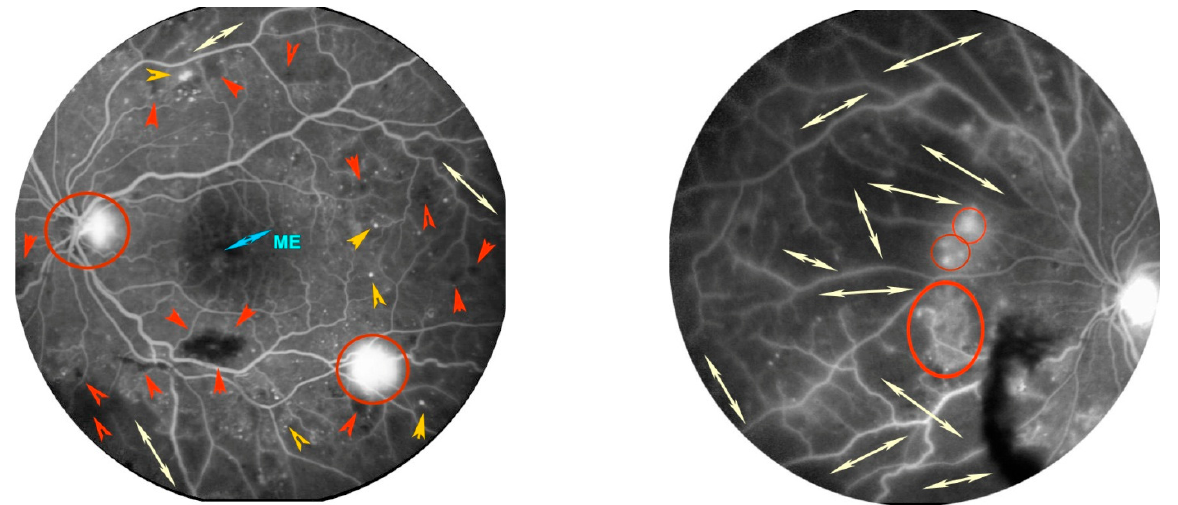
Figure 3. Fluorescein angiography of a patient with proliferative diabetic retinopathy (DR) in left eye. Posterior pole in the left image. Presence of numerous microaneurysms as hyperfluorescent dots (orange arrow heads), bleeding as irregular black spots (red arrow heads), and initial macular edema (ME) as retinal foveal hyperfluorescence. Retinal nasal quadrant in the right image. Presence of large dark areas without terminal vessels due to retinal ischemia (white arrows). In both images, some hyperfluorescent spots on the optic disc and along the nasal and temporal vascular arches are highlighted, due to proliferation of new blood vessels (red circles).